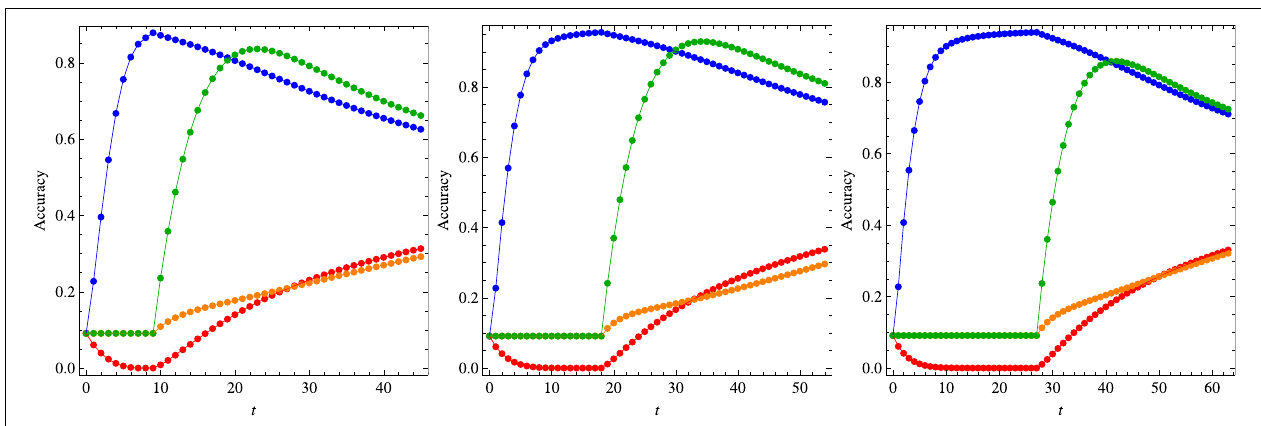
association ( w 7 , o 7 ) and the orange symbols on association ( w 7 , o 1 ) . The left panel shows the results for 3 repetitions of w 1 in the early training phase ( α 0 = 0 . 85, χ = 0 . 25, β = 0 . 95), the middle panel for 6 repetitions ( α 0 = 0 . 85, χ = 0 . 45, β = 0 . 99) and the right panel for 9 repetitions ( α 0 = 0 . 85, χ = 0 . 4, β = 0 . 95). For each trial t the symbols represent the average over 10 5 realizations of the learning